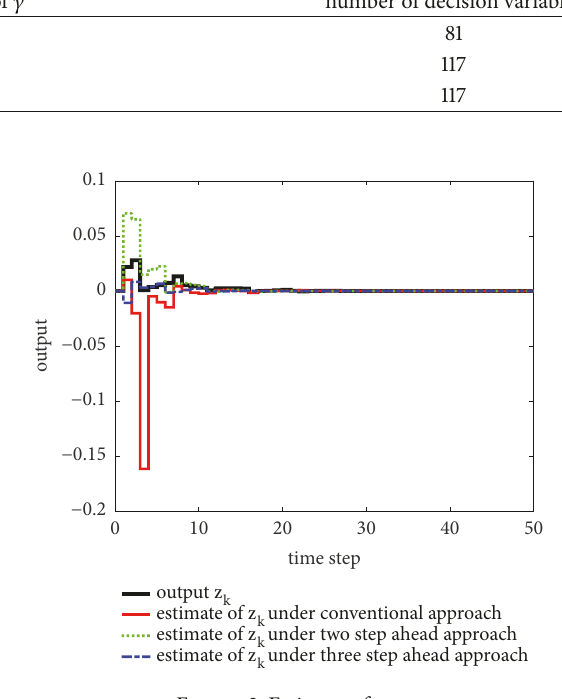
Figure 3: Estimate of 𝑧 𝑘 .